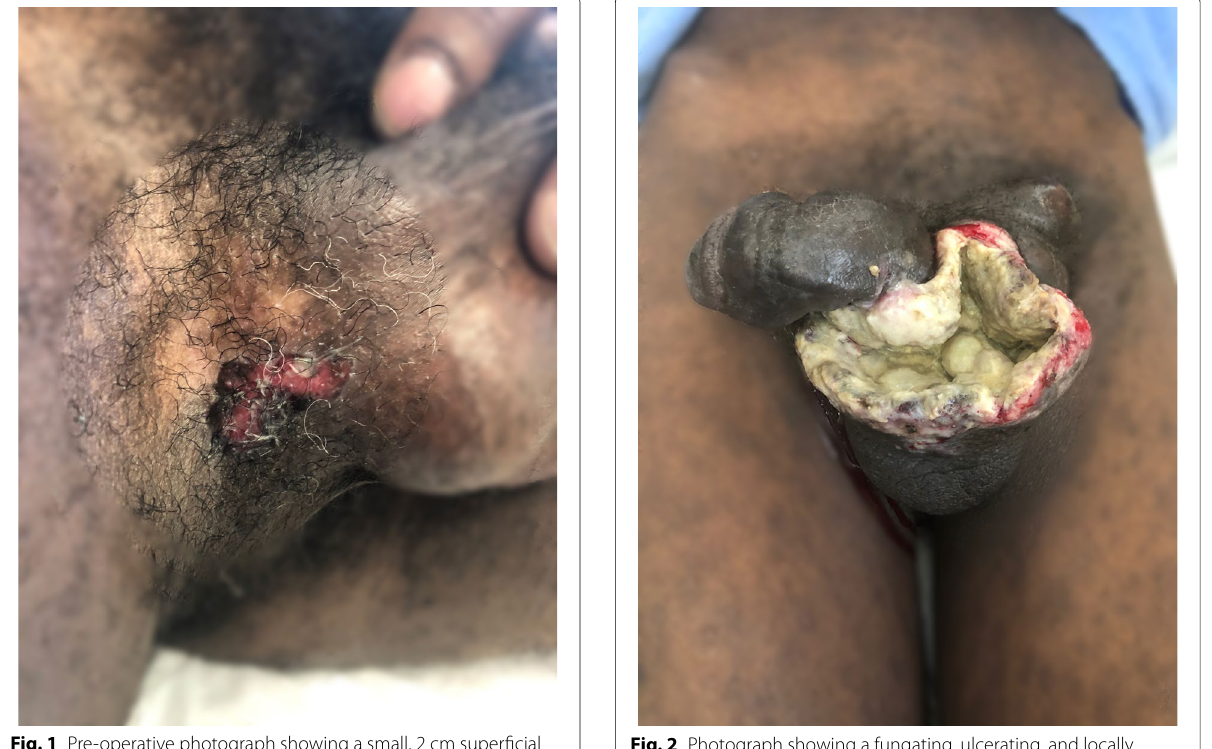
Fig. 2 Photograph showing a fungating, ulcerating, and locally destructive mass with rolled edges involving most of the scrotum and the base of the